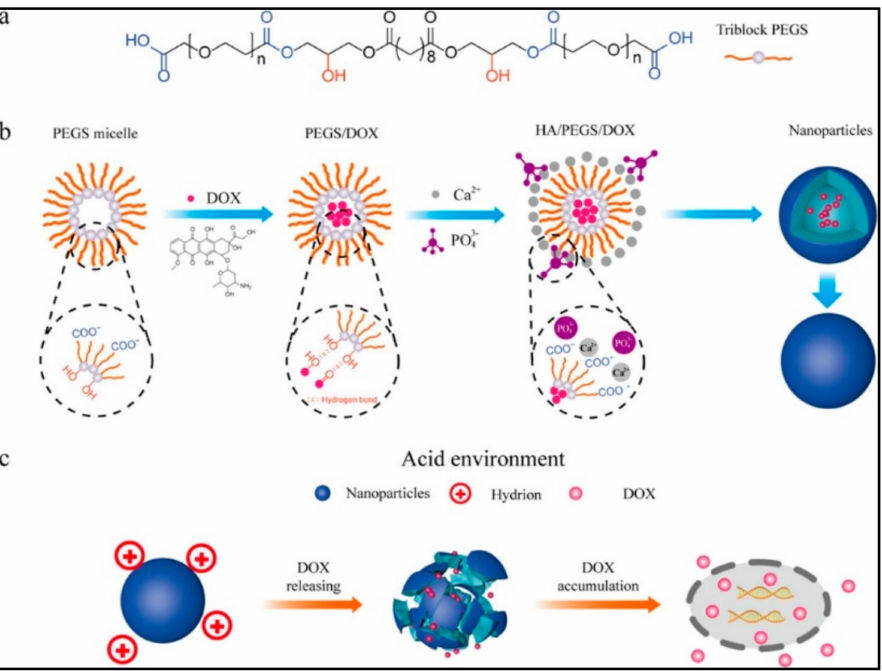
Figure 7. ( a ) Chemical Structure of the prepared polymer (PEGS). ( b ) Preparation strategy of PEGS/HA/DOX delivery system. ( c ) DOX release mechanism in acidic tumor environment. Reprinted with permission from [161]. Copyright © 2020, American Chemical